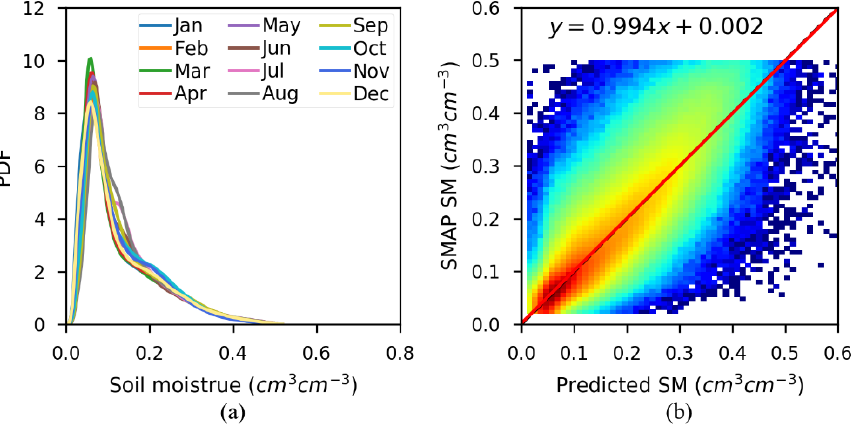
Figure 7. Monthly SMAP soil moisture probability density function ( a ) and density scatterplot of GNSS-R derived soil moisture and surface SM reference values in a split of k-fold cross-validation ( b